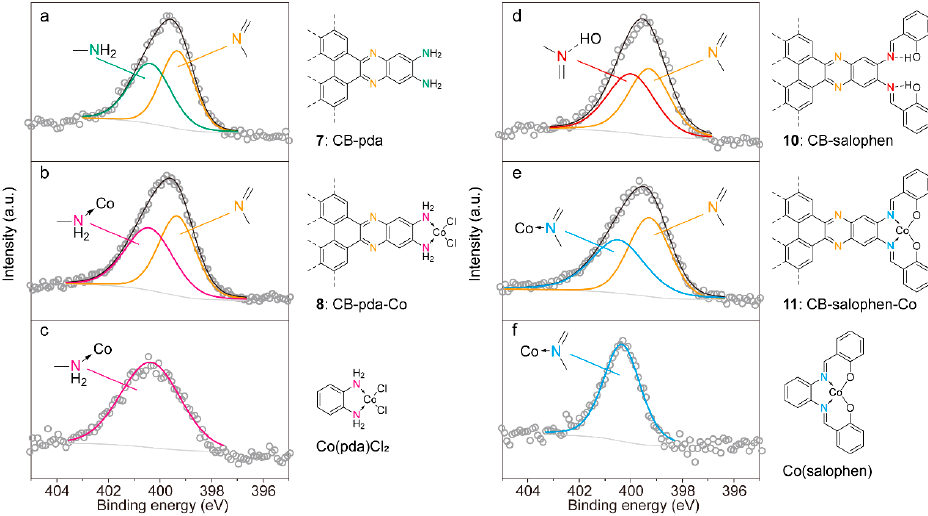
Figure 4. N 1s XPS of ( a ) CB-pda, ( b ) CB-pda-Co, ( c ) [Co(pda)Cl 2 ], ( d ) CB-salophen, ( e ) CB-salophen- Co and ( f ) Co(salophen). Circles show the data and lines show the fitting curve.